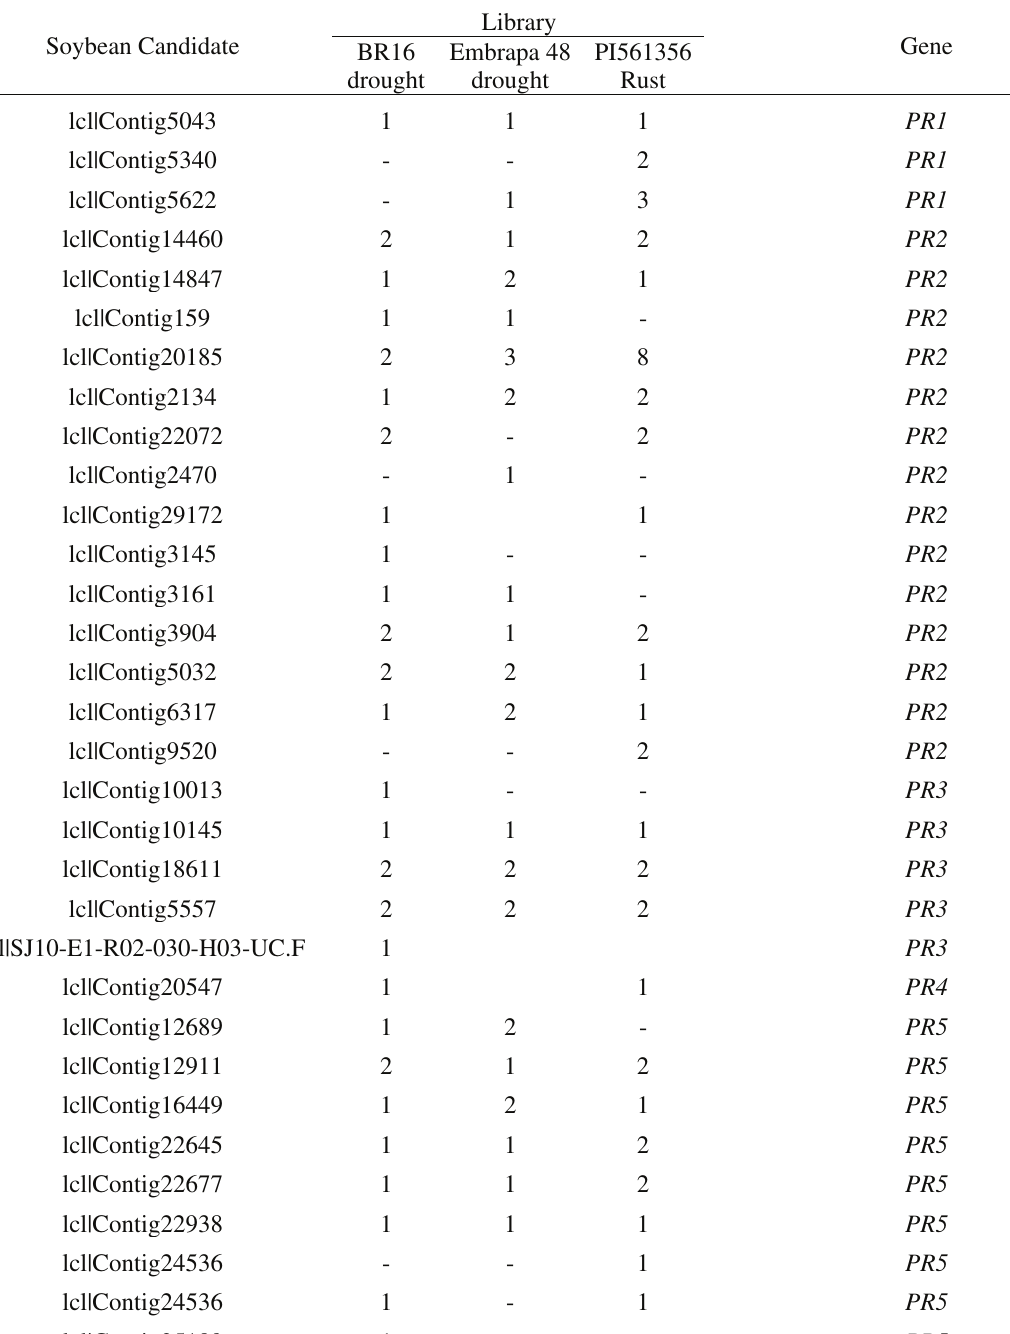
Table S2 - Number of SuperSAGE tags per comparison (stressed library versus negative control for each gene family) that aligned with soybean candidates. Comparisons regarded: (1) BR-16 (drought susceptible stressed plants vs. negative control); (2) Embrapa-48 (drought tolerant plants after stress vs. negative control), and (3) PI561356 (rust fungus resistant plants after stress vs. negative